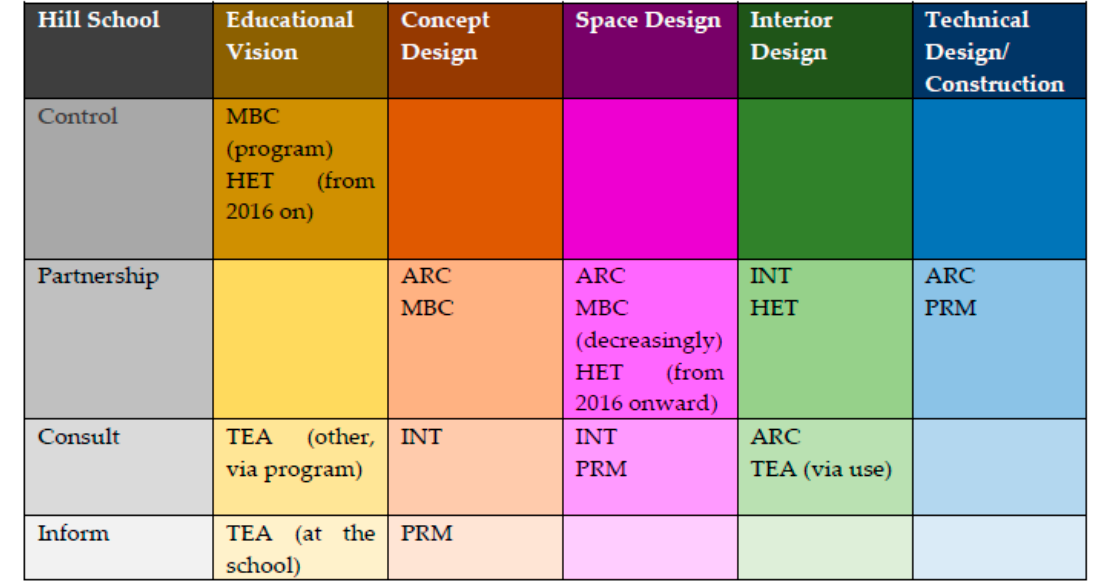
Figure 5. The ECSIT model plotting stakeholder influence in different phases of the design and building process at Hill School. ARC: architect; HET: head teacher; INT: interior designer; MBC: municipality’s school building coordinator; PRM: property manager; and TEA: teachers.